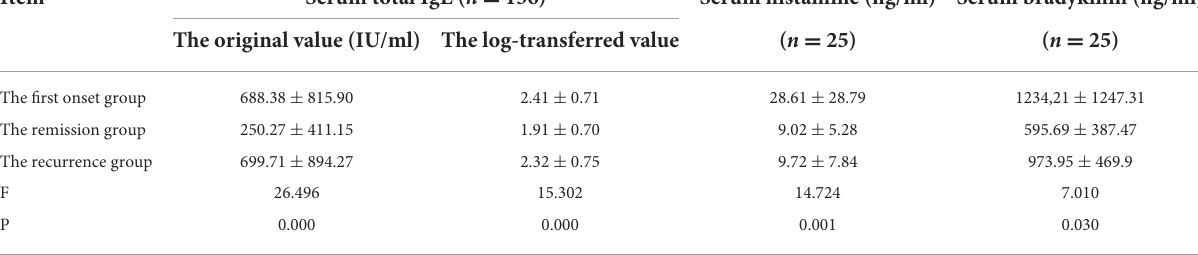
TABLE 2 The changes in the serum total IgE, histamine and bradykinin in children with PNS at the first onset, remission and relapse groups. Item Serum total IgE ( n = 136) Serum histamine (ng/ml) Serum bradykinin (ng/ml) The original value (IU/ml) The log-transferred value ( n = 25) ( n = 25)